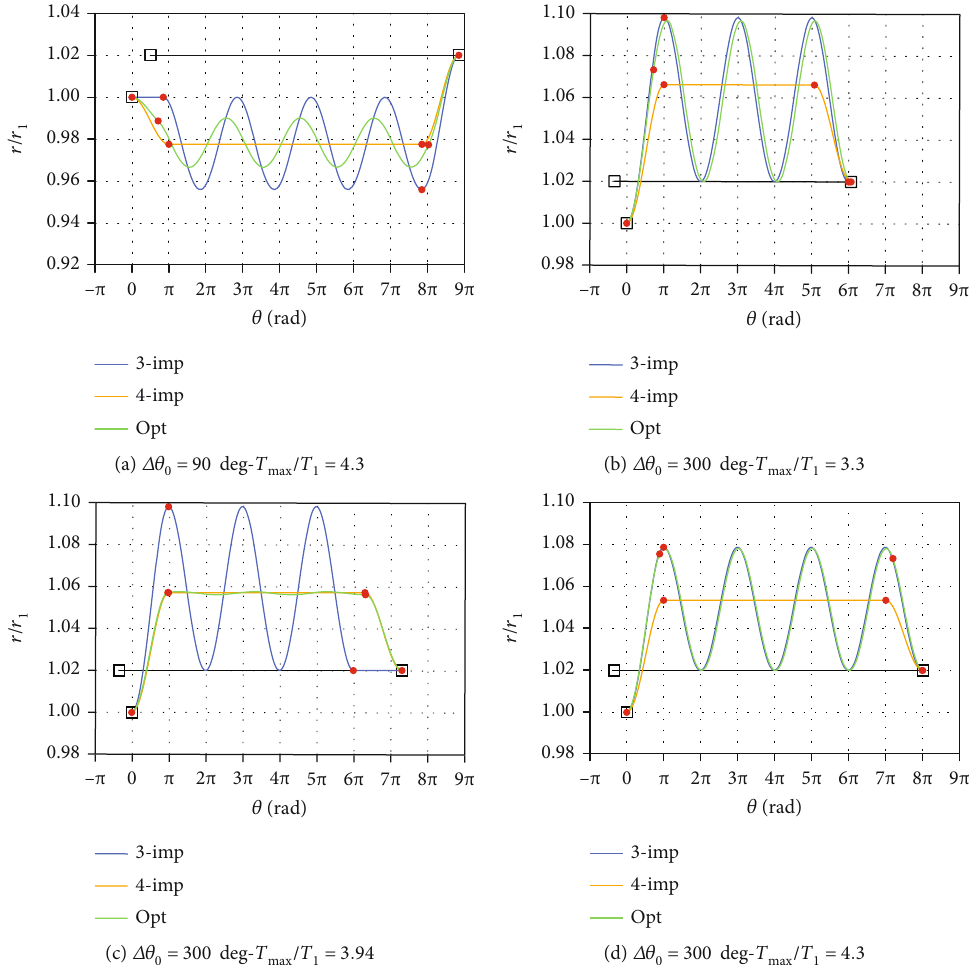
Figure 8: Optimal and suboptimal chaser trajectories. Black lines show the constant-radius target trajectory. Empty squares mark initial and fi nal positions. Red dots indicate impulsive